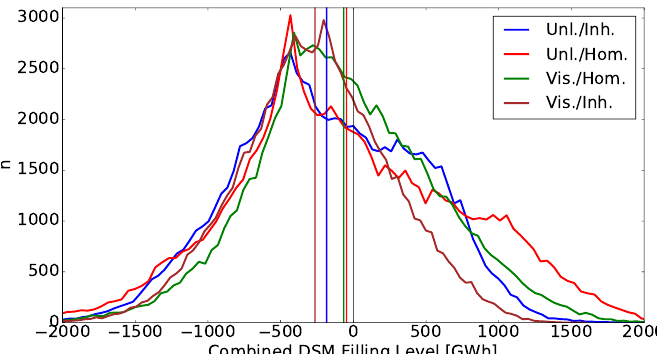
Figure 5. Frequency distribution of combined DSM storage filling levels. Vertical lines indicate the